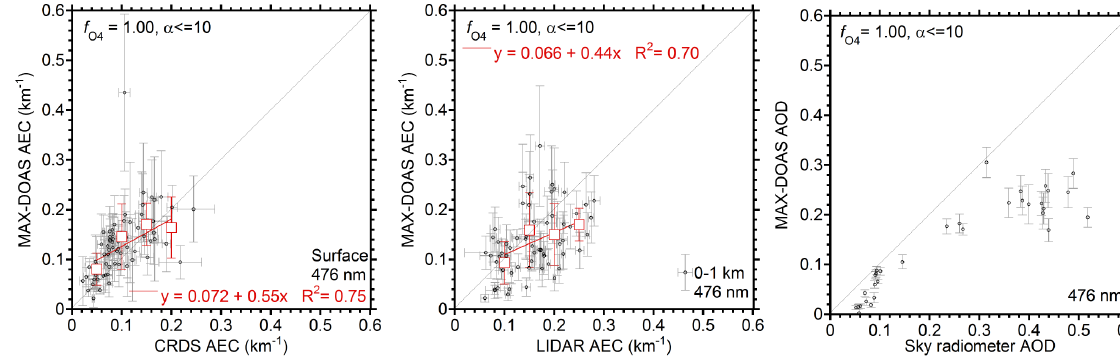
=1.00 is assumed in the MAX-DOAS retrieval. α used in the retrieval was limited to ≤ 10 ◦ . Figure 14. Same as Fig. 5, but a f O 4